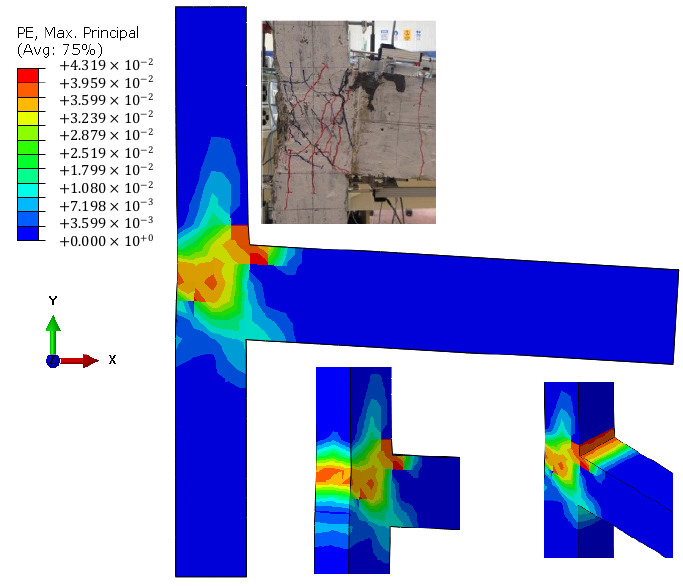
Figure 10. Damage plot for the Joint J1 in combination with the experimental observation. Table 2. Error estimation with GCI.